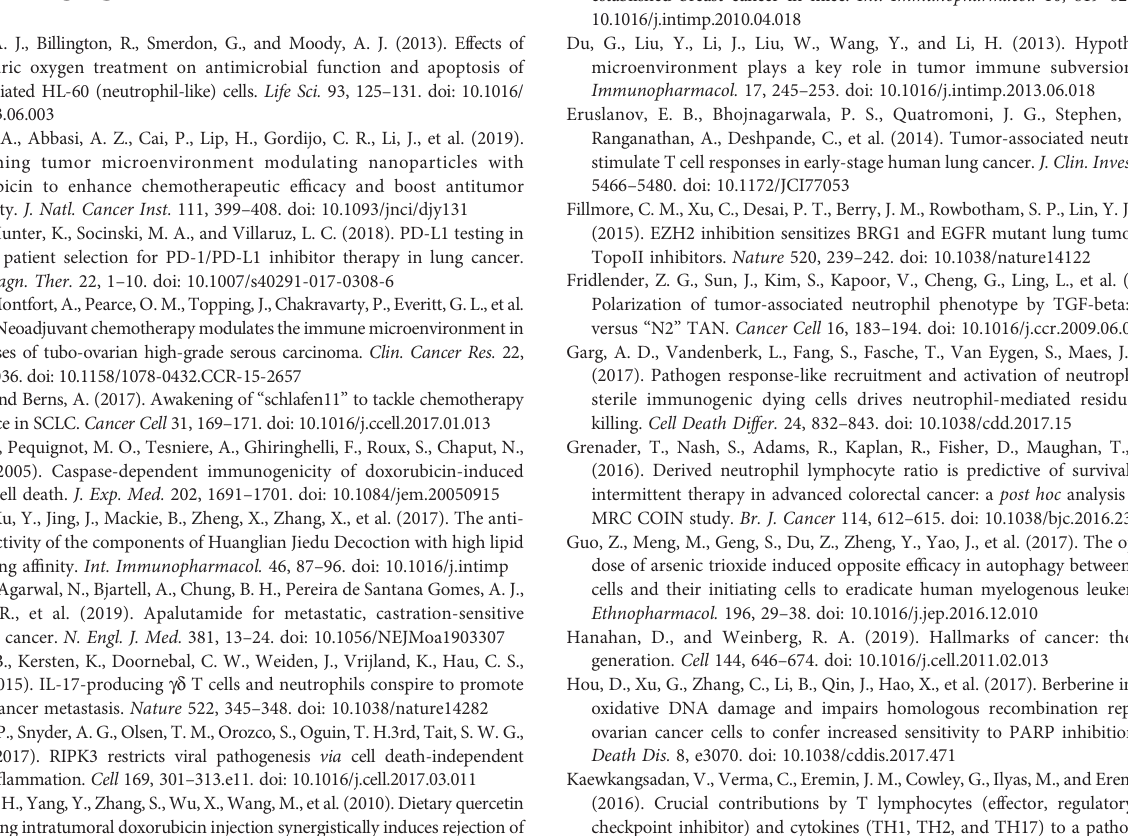
SUPPLEMENTARY FIGURE 4 | Serum cytokine levelsin tumourallograft. (n = 6). Thedata present Mean ± SD, the experiments were repeated 3 times, and statistical